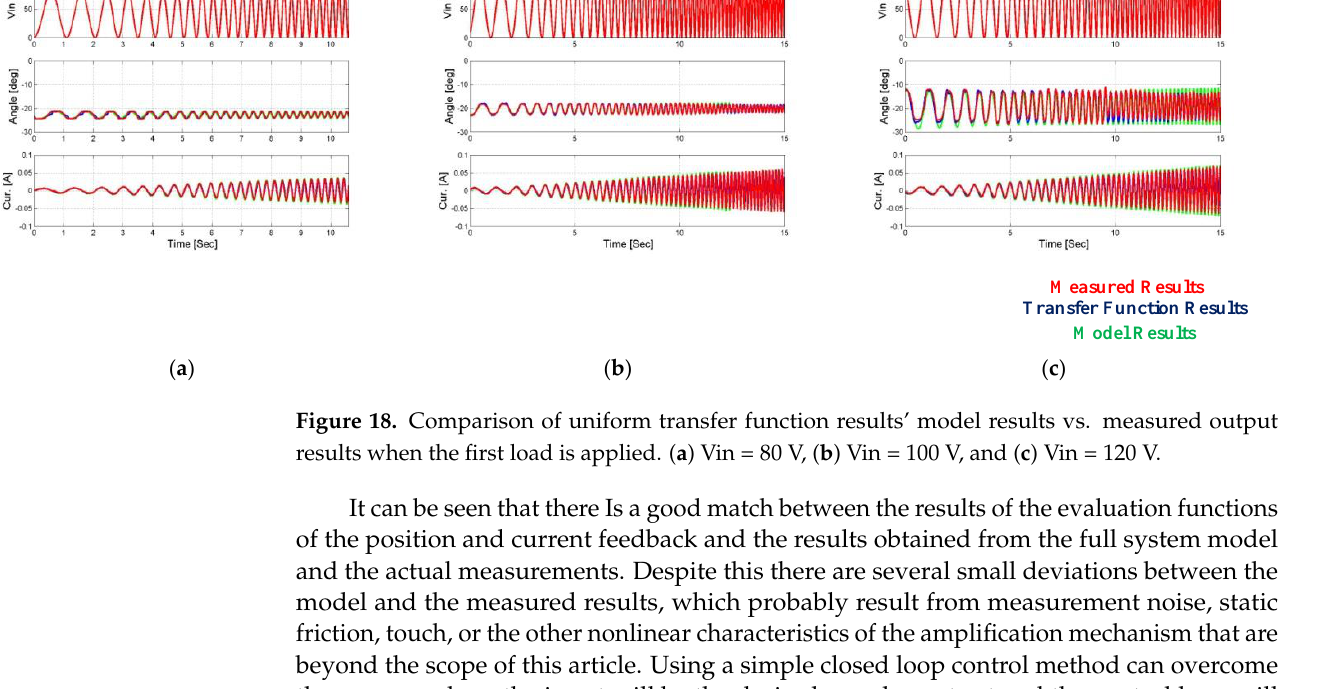
Figure 19. Comparison of uniform transfer function results ’ model results vs. measured output re- sults when the second load is applied. ( a ) Vin = 80 V, ( b ) Vin = 100 V, and ( c ) Vin = 120 V.